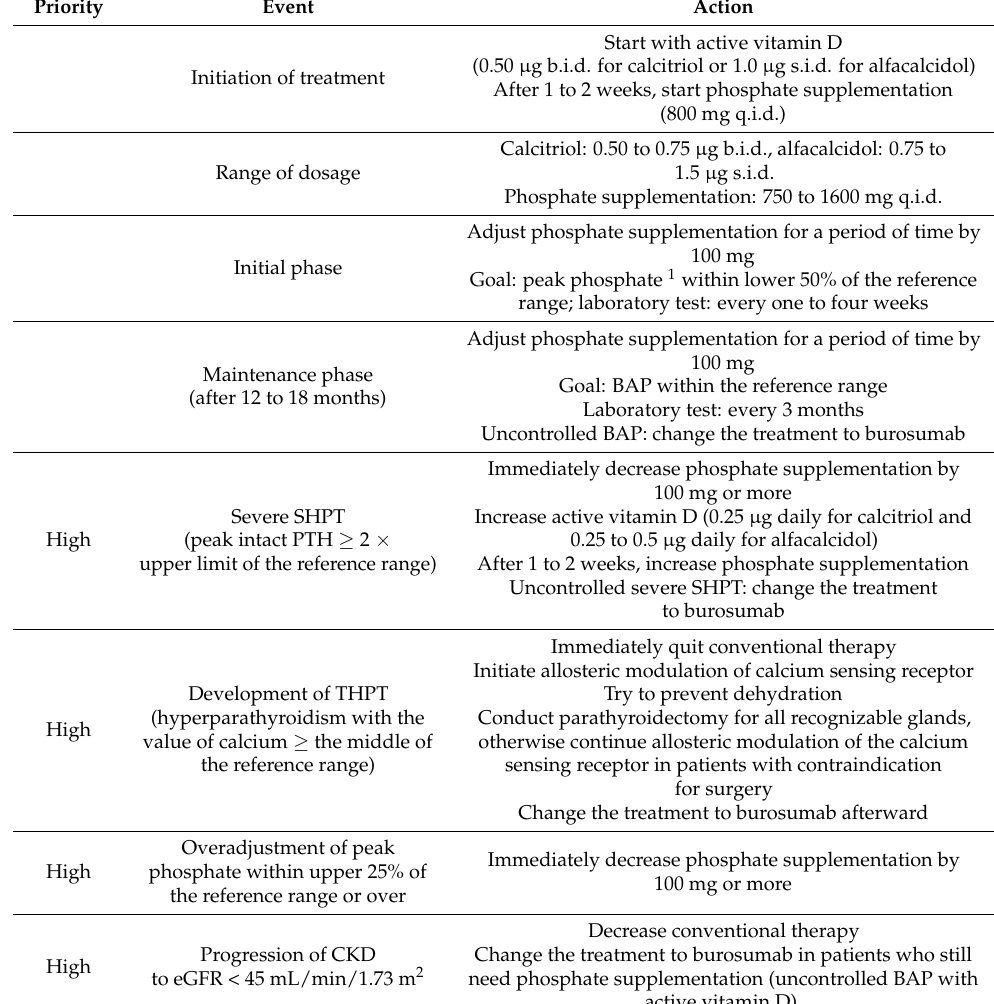
Table 2. Suggested guidance of conventional therapy for adult XLH patients.